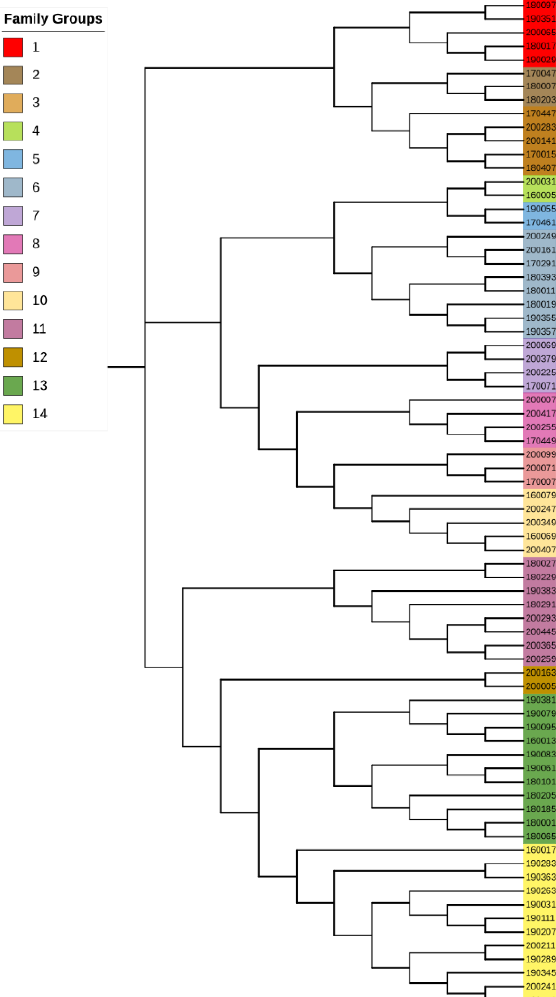
Figure 4. NJ tree in Tan sheep .